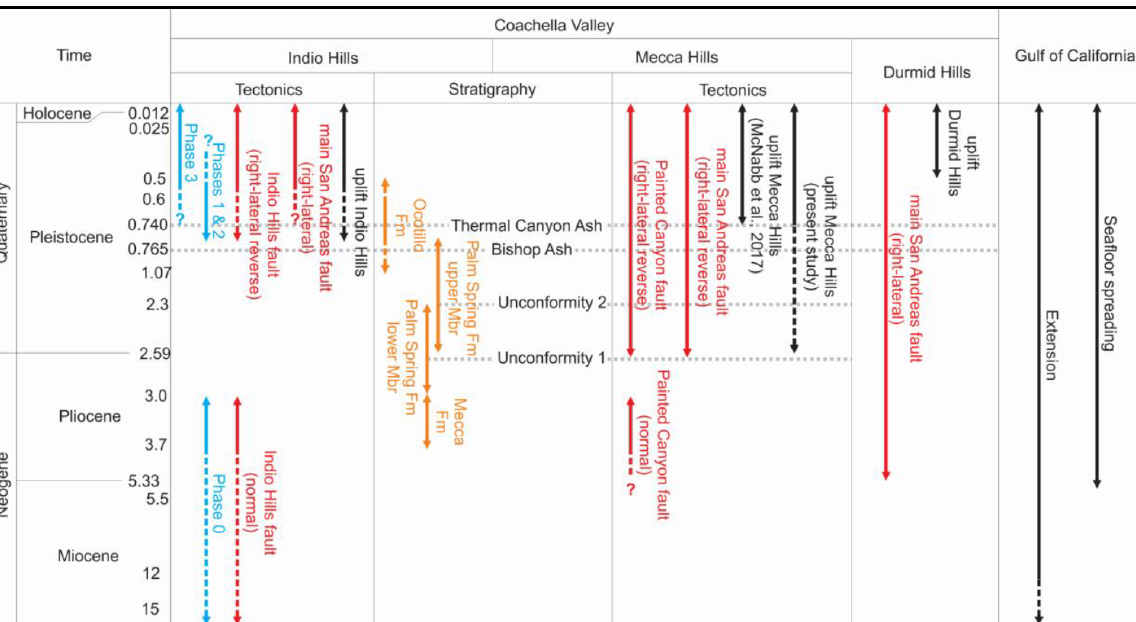
Table 1. Summary of the timing of the main events in the Coachella Valley and Gulf of California. Note the presumed timing phases (1–3) of fold-faulting and uplift events in the Indio Hills (this work). The stratigraphy is common to the Mecca Hills and Indio Hills, although some features are only observed in one area (e.g., unconformities 1 and 2 in the Mecca Hills but not in the Indio